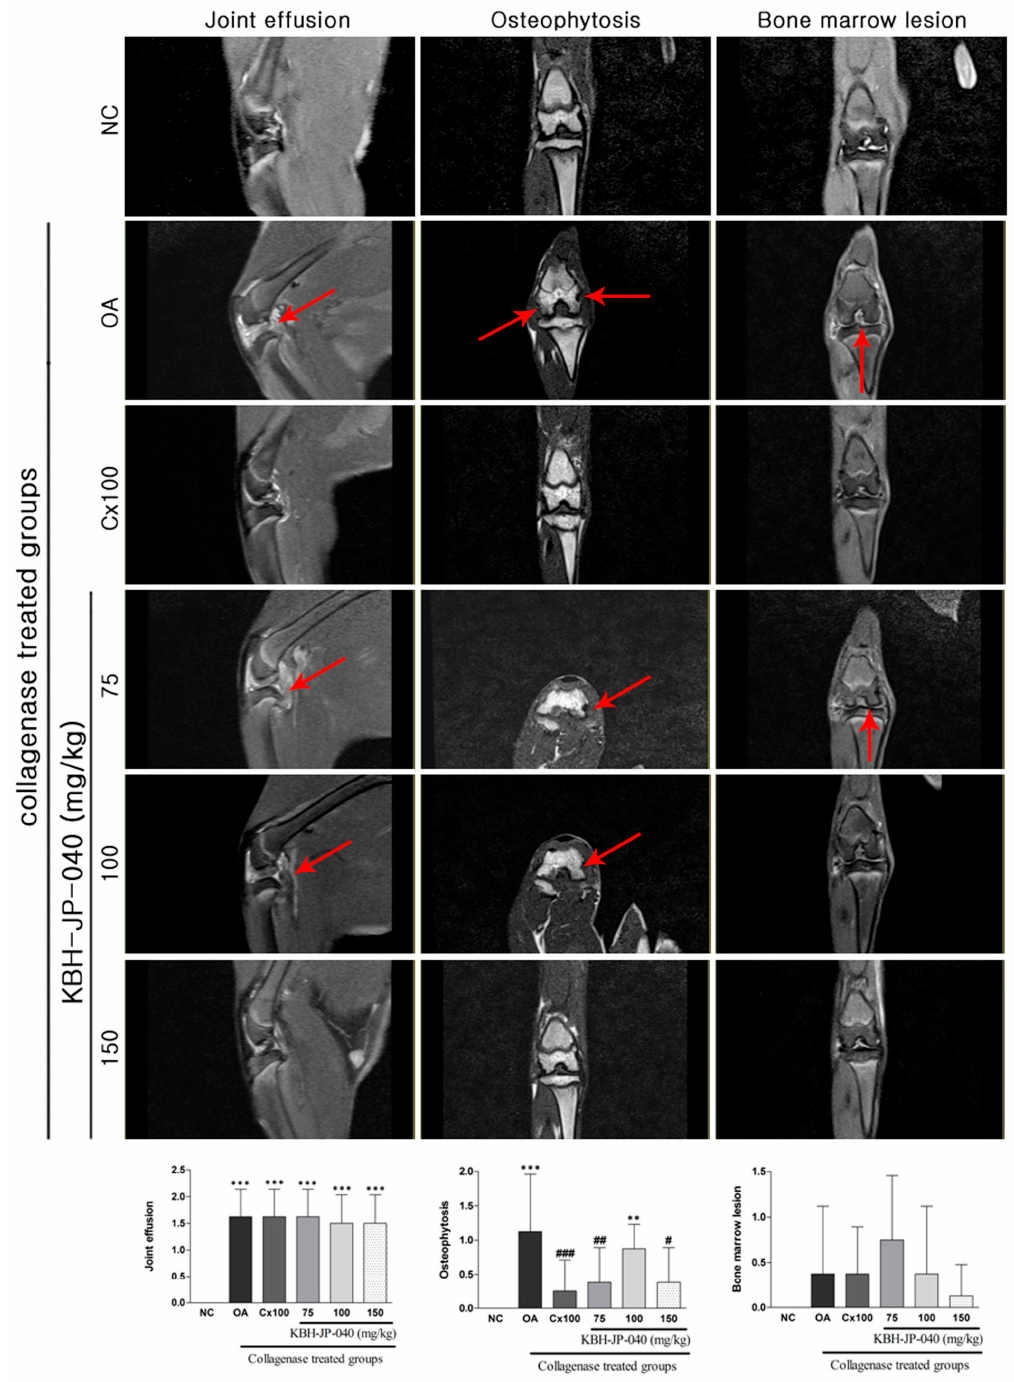
Figure 4. Evaluation of therapeutic efficacy of KBH-JP-040 by MRI images. NC, vehicle-treated normal control group; OA, vehicle-treated collagenase-induced osteoarthritis group; Cx100, collagenase-induced OA rabbits treated with celecoxib 100 mg/kg; collagenase-induced OA rabbits treated with standardized extract, KBH-JP-040-treated groups (75, 100, and 150 mg/kg body weight). Joint effusion, osteophytosis, and bone marrow lesions were (marked by arrow) present in OA group. These alterations were improved in the KBH-JP-040 150 mg/kg- and celecoxib-treated group. The data are reported as means ± SD ( n = 10). **: p < 0.01; and ***: p < 0.001, Bonferroni post hoc test following one-way ANOVA versus the NC group; #: p < 0.05; ##: p < 0.01; and ###: p < 0.001, Bonferroni post hoc test following one-way ANOVA versus OA group.